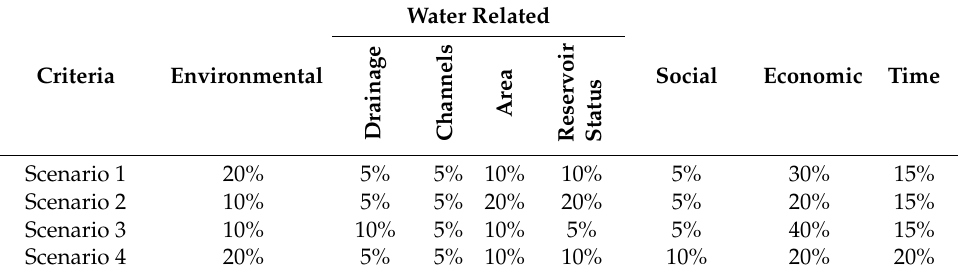
Table 3. Scenarios for criteria weighting